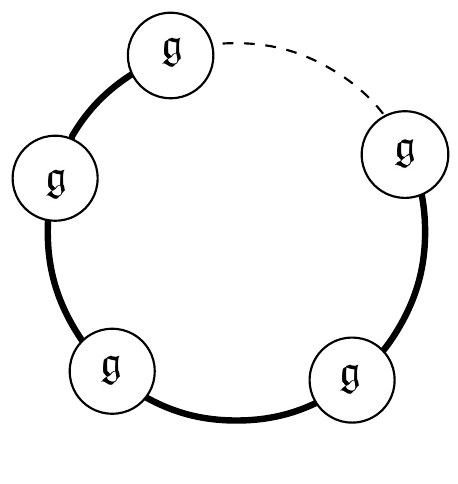
Figure 5. Quiver for the theory T A after circle reduction to (cid:12)ve dimensions. The thick lines g ;N connecting the nodes correspond to generalized bi-fundamental matter.